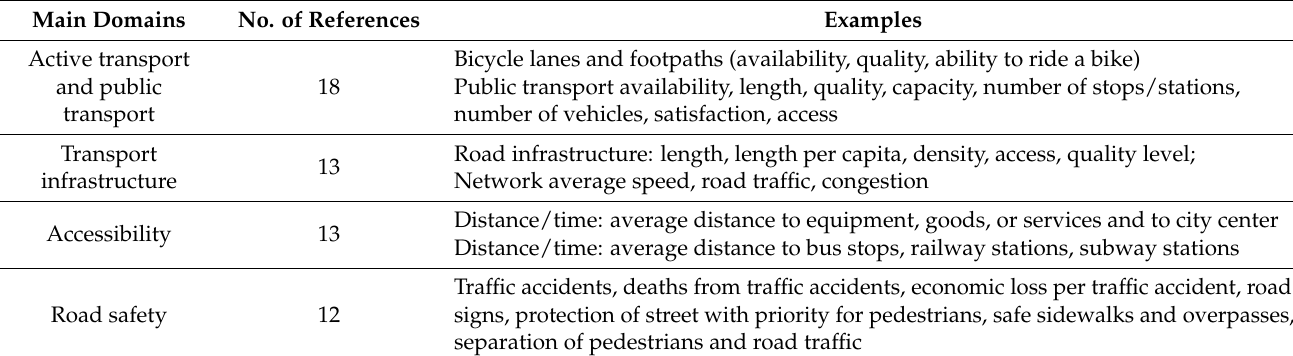
Table 1. Domains/indicators of transport and urban mobility for measuring urban